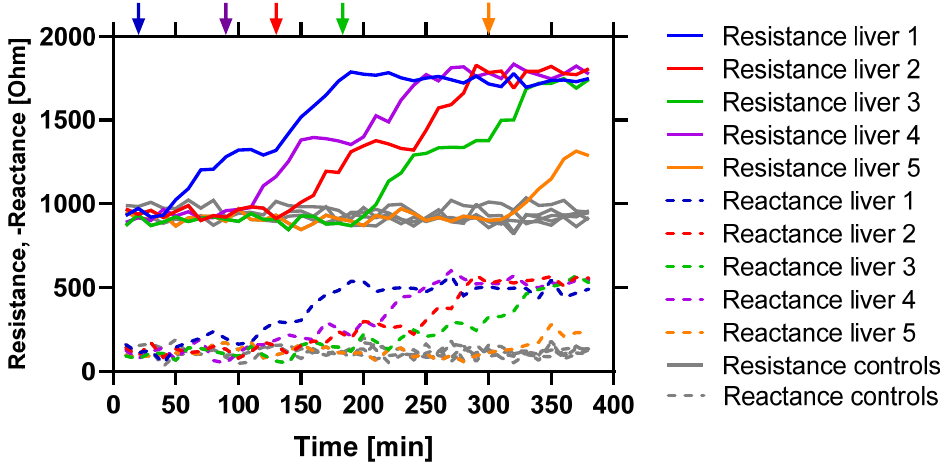
Figure 4. Example of simulated resistance and reactance data at 100kHz for five livers (in colors) having random onsets of ischemia (marked with arrows). Five non-ischemic control livers are added in gray. The data are simulated with a 5% liver variation, no drift, and a noise level of 30